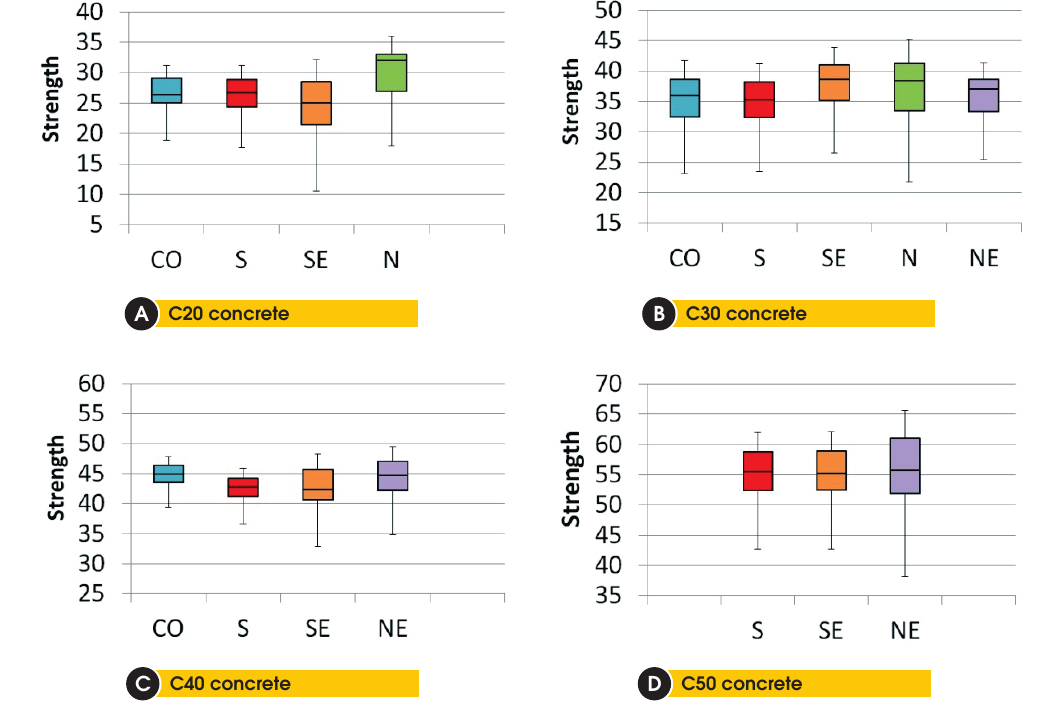
Box-and-whiskers representation for the samples according to the